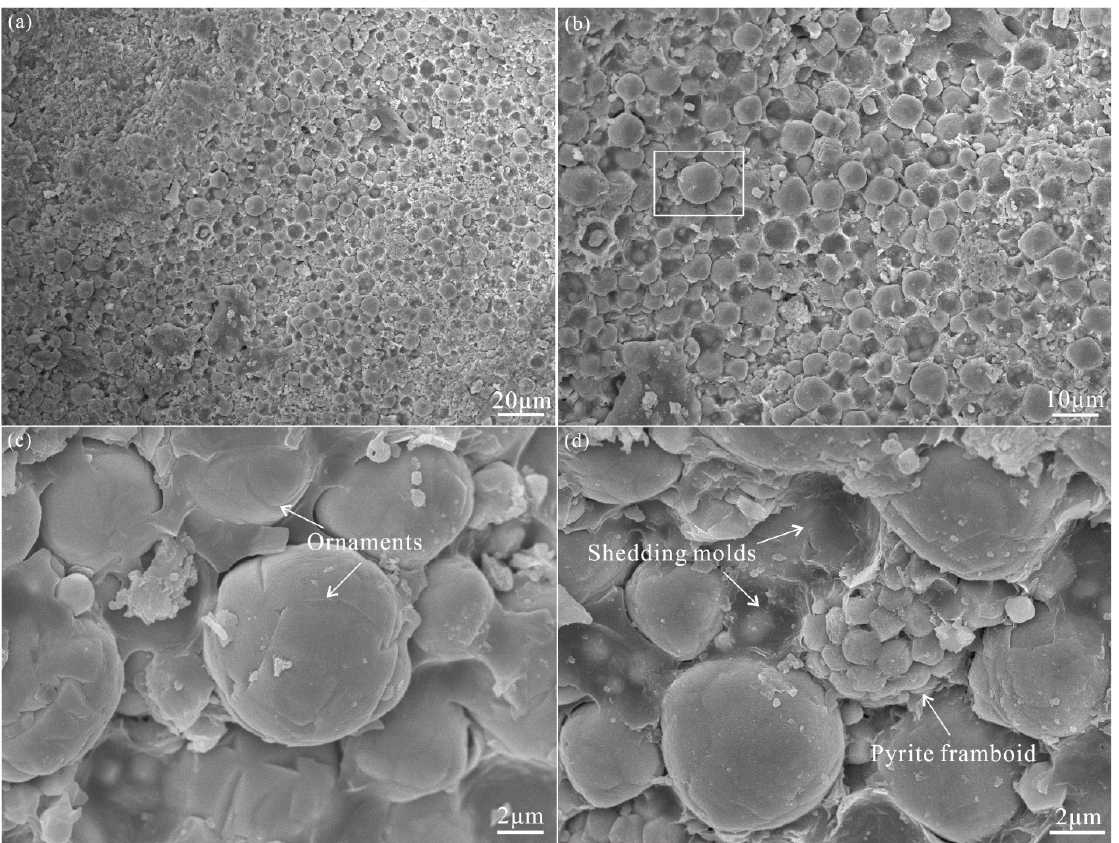
Figure 4. Microscopic photographs of Microcystis in the upper Lucaogou Formation (J-17, 3574.2 m). ( a ) Microcystis colony. ( b ) Magnified view of ( a ); abundant, randomly arranged globular to elliptical shaped individuals. ( c ) Close-up of the rectangle in ( b ); ornaments are visible on the cell surface. ( d ) Microcystis individuals, pyrite framboids, and their shedding molds.